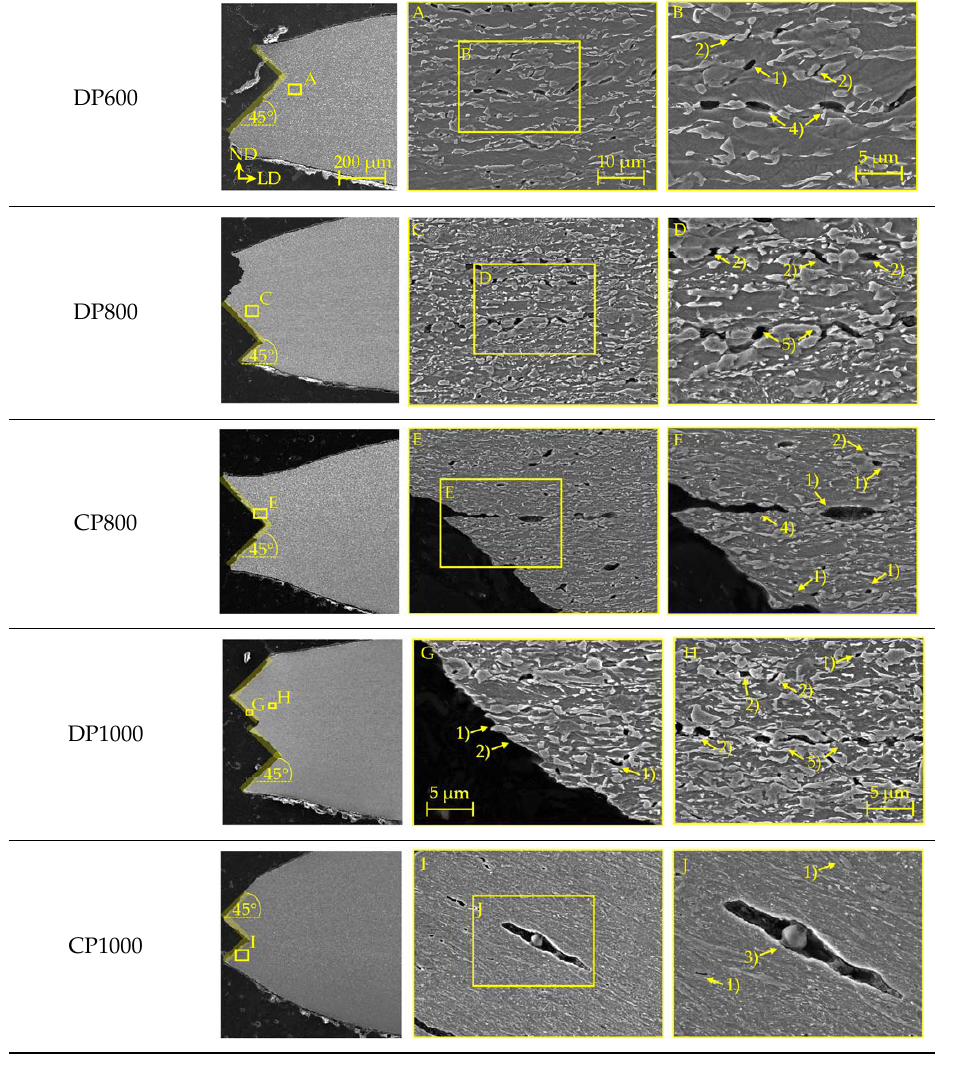
Table 7. Damage mechanisms (scanning electron microscopy (SEM) micrographs): (1) Void nucleation between martensite and matrix; (2) Void nucleation due to martensite particle fracture; (3) Void nucleation due to inclusion-matrix decohesion; (4) Damage evolution along grain boundaries; (5) Damage evolution along martensite rows.